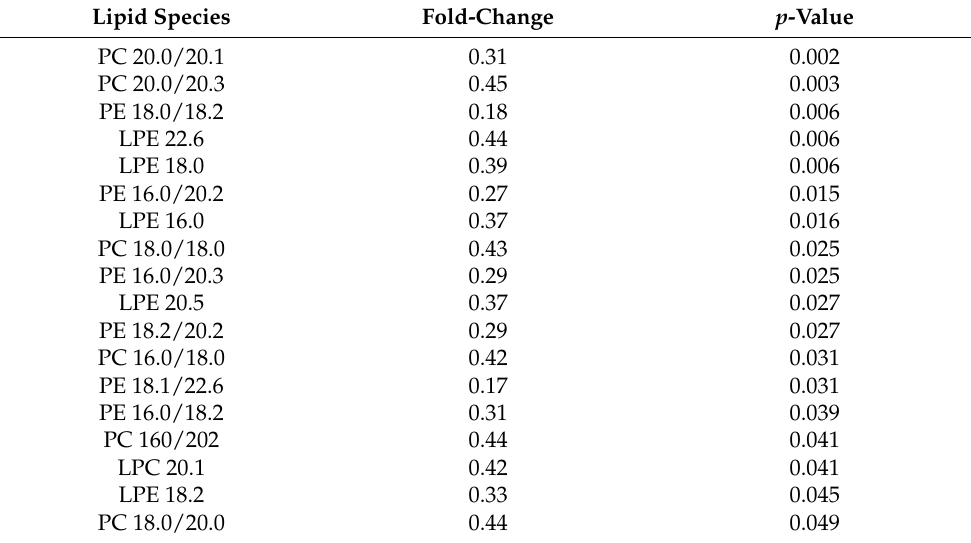
Table 1. Important lipid features selected, fold changes (FCs) and p